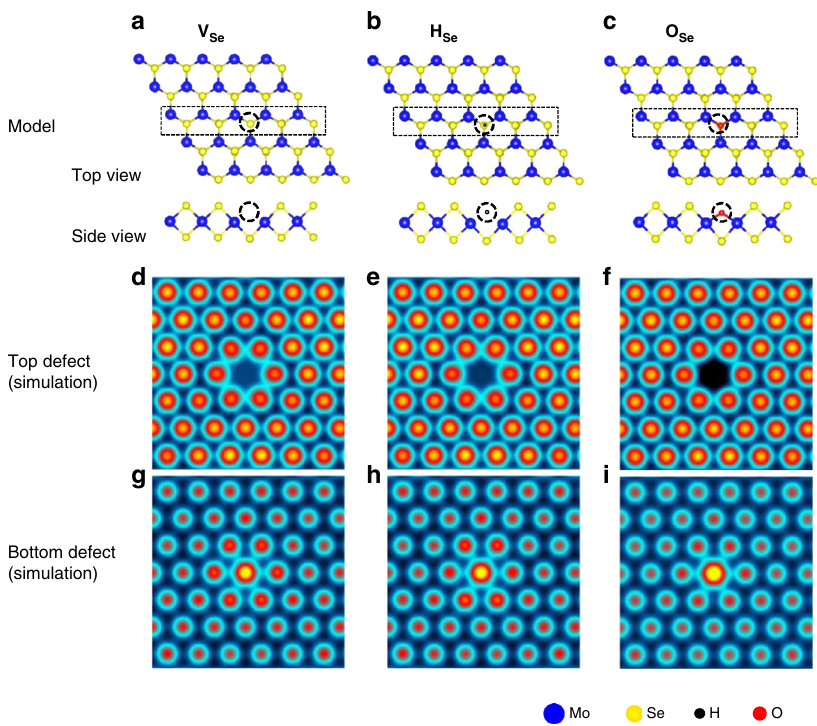
Fig. 3 Nc-AFM CO-tip simulation of a Se vacancy, H and O substitution. Atomic structure from DFT relaxed coordinates of a a Se vacancy ( V Se ), b hydrogen substitution ( H Se ), and c oxygen substitution ( O Se ) at a chalcogen site in a single layer of MoSe 2 . Simulations of the nc-AFM images using a previous established method by Hapala et al. 33 of V Se , H Se , and O Se placed both d – f in the top layer (Se-sublattice facing the tip) and g – i in the bottom layer (Se-sublattice facing the underlying graphene layer), respectively